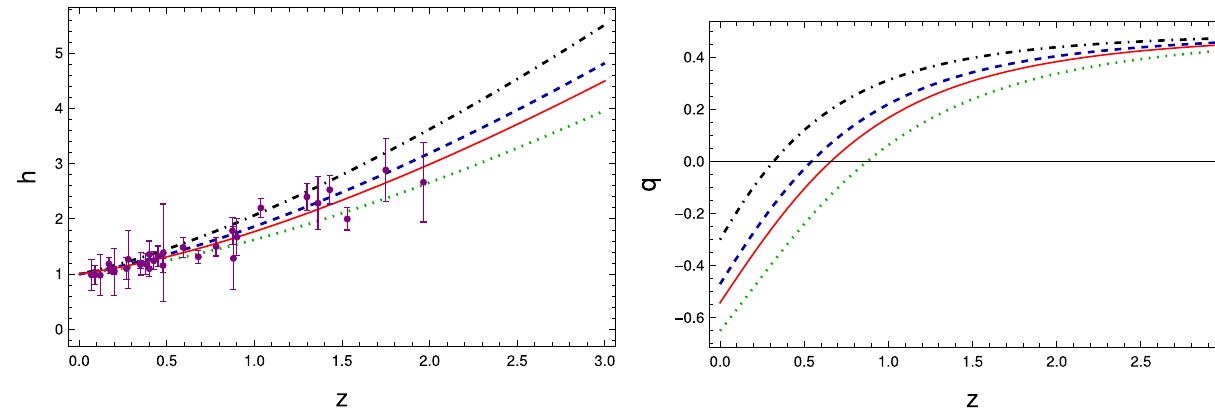
Fig. 1 The Hubble function h ( z ) and the deceleration parameters q ( z ) of the model (83), corresponding to the best-fit values of (cid:20) (dashed), (cid:20) = 3 . 2 (dot-dashed), and (cid:20) = 4 . 6 (dotted). The solid line corresponds to the (cid:2) CDM model, and the error bars indicate the observational data with their errors